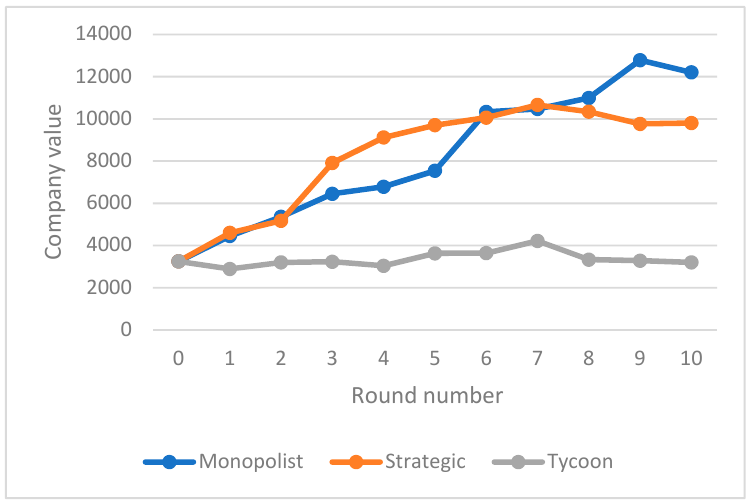
Figure 14. Comparison between different difficulty levels.